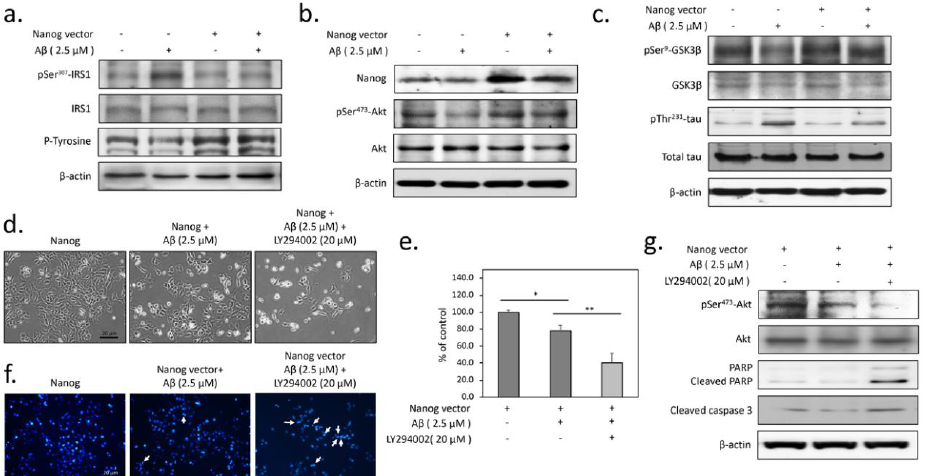
Figure 2. Overexpression of Nanog inhibits A β -induced tau phosphorylation and cytotoxicity by restoring impaired insulin signaling; ( a ) western blots showed that treatment with 2.5 µ M of A β for 24 h induces a marked increase of insulin receptor substrate 1 (IRS-1) Ser 307 phosphorylation, a major marker of insulin resistance. However, overexpression of Nanog greatly inhibited this phosphorylation; ( b ) western blot analysis of Ser 473 phosphorylated Akt confirmed that overexpression of Nanog reverses A β -induced insulin signaling blockade; ( c ) western blot results indicated that overexpression of Nanog inhibits A β -induced tau phosphorylation at Thr 231 and increases the phosphorylation of glycogen synthase kinase 3 β (GSK3 β ) at Ser 9 ; ( d ) Bright field images showed that Nanog-induced protection is abolished by the co-treatment with LY294002 (20 µ M), a specific inhibitor of PI3-kinase; ( e ) MTT reduced Nanog-induced anti-nucleus fragmentation e ff ects determined by using DAPI staining. The arrows indicated apoptotic cells with nuclear fragmentation; ( g ) western blots showed that LY294002